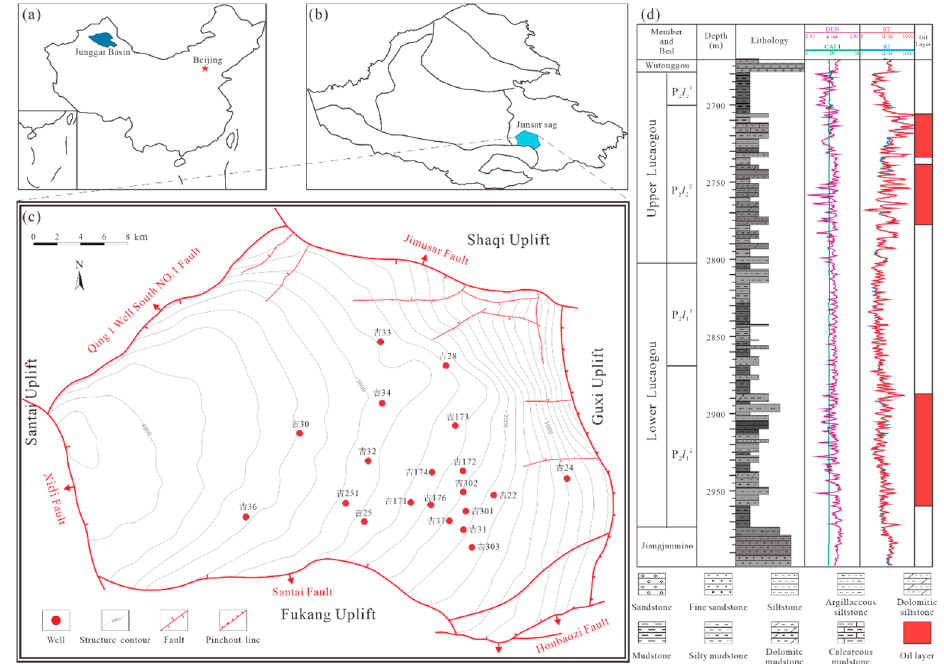
Figure 1. ( a ) Location of the Junggar Basin in north-western China; ( b ) location of Jimsar sag in the south-eastern Junggar Basin; ( c ) structural configuration of the Jimsar sag and location of wells sampled in this study; and ( d ) generalized stratigraphy and lithology of Jimsar sag with oil layer